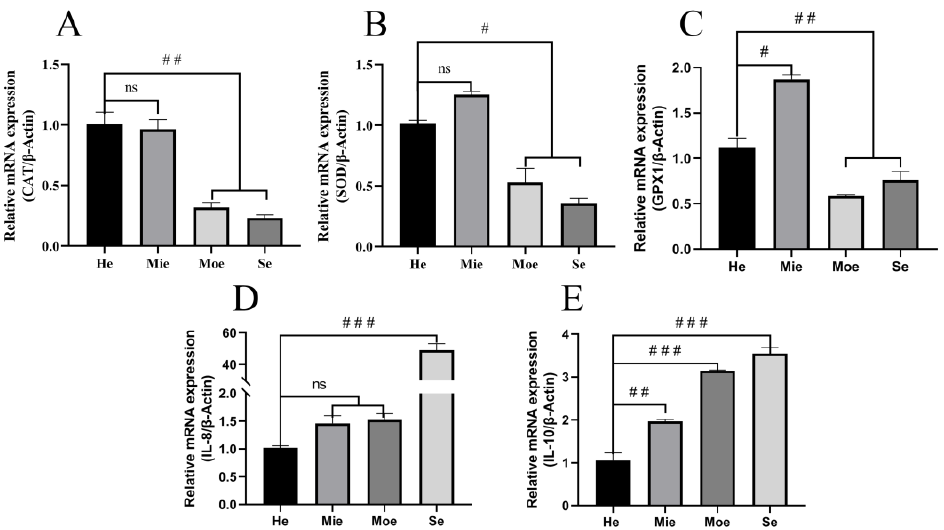
Figure 2. The mRNA expression levels of antioxidant stress related enzymes CAT ( A ), SOD ( B ), GPx ( C ) and inflammation-related IL-8 ( D ), IL-10 ( E ) in uterine tissue were assessed by RT-qPCR. The experiment was repeated three times. Expression data were normalized to that of β-actin. One-way ANOVA analysis was used to compare to the control group. Significance differences are marked as # p < 0.05, ## p < 0.01, ### p < 0.001, ns no significance.